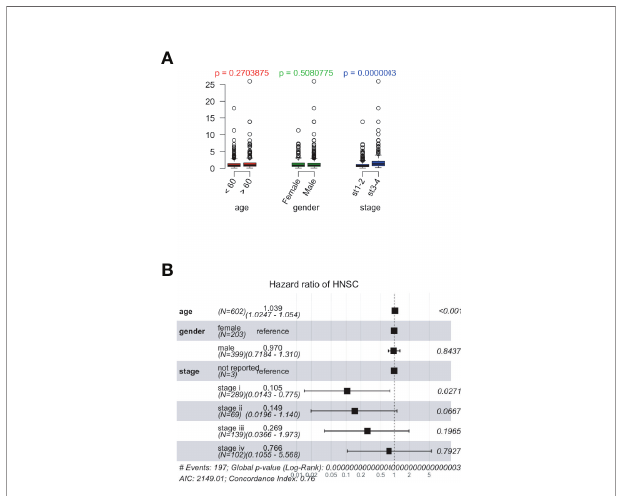
FIGURE 5 | The relationship between risk scores and clinical features in The Cancer Genome Atlas (TCGA) database. The risk scores were calculated based on the correlation between identi fi ed prognostic genes and patient ’ s clinical data. (A) Dot plots presenting the risk score distribution of age, sex, and clinical stages in the TCGA database. (B) Forest plots showing risk scores and clinical features in TCGA dataset.